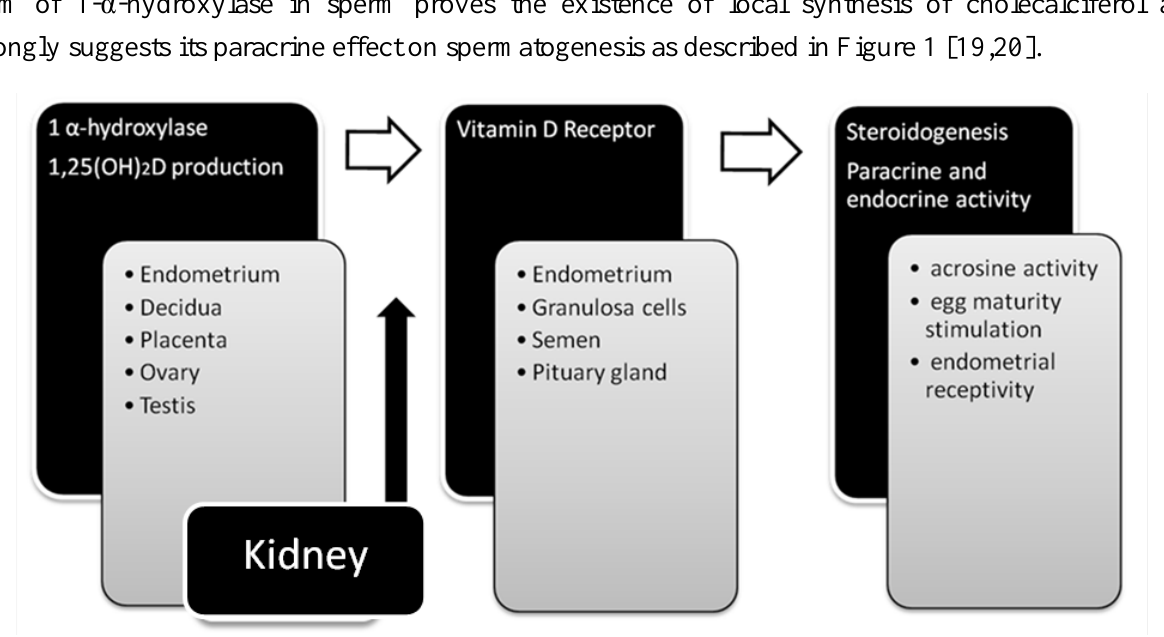
Figure 1. The role of vitamin D in the reproductive system (after: Grzechocinska B, Dabrowski FA, Cyganek A, Wielgos M. The role of vitamin D in impaired fertility treatment